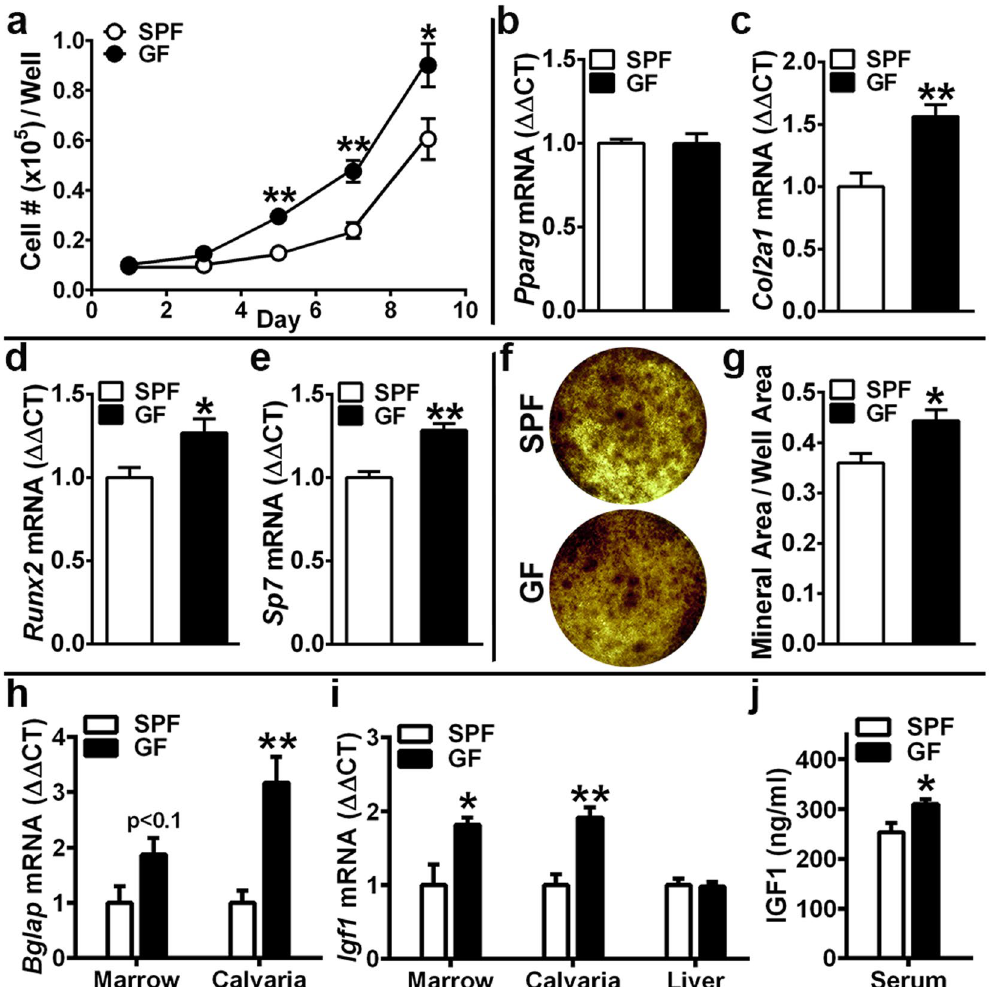
Figure 2. Osteoblastogenesis investigations. ( a – g ) Bone marrow stromal cell (BMSC) in vitro osteoblastogenesis assays. 11 week-old male SPF & GF mice were euthanized; bone marrow harvested; BMSCs isolated for in vitro assays. ( a ) Cell expansion assay (n = 4/gp): cell numbers over time in culture. ( b – e ) BMSC differentiation potential assay (untreated day-4 pre-confluent cultures were harvested for qRT-PCR analysis) to assess intrinsic differentiation potential (n = 4/gp). ( b ) Pparg mRNA assessed as a marker of adipogenic potential. ( c ) Col2a1 mRNA assessed as a marker of chondrogenic potential. ( d ) Runx2 and ( e ) Sp7(Osterix) mRNA assessed as markers of osteoblastogenic potential. Relative quantification of mRNA was performed via the comparative C T method ( ΔΔ CT); Gapdh was utilized as an internal control gene; data expressed as fold difference relative to SPF. ( f , g ) von Kossa mineralization assay (21 day mineralization treatment) (n = 4/gp). ( f ) Representative von Kossa stained culture images. ( g ) Mineralization area per well area. ( a – g ) BMSC assays carried out in duplicate (two technical replicate) cultures; n-values represent biological replicates per group. ( h – j ) Commensal microbiota in vivo regulation of osteoblastogenesis. 11 to 12 week-old male SPF & GF mice were euthanized; tissues were harvested. (h,i) RNA was isolated from marrow (n = 4/gp), calvaria (n = 4/gp), liver (n = 6/gp) for qRT-PCR analysis of candidate osteogenic genes. ( h ) Bglap(Osteocalcin) mRNA assessed as a marker of mature osteoblast function, and ( i ) Igf1 mRNA assessed as a critical osteoblastic signaling factor. Relative quantification of mRNA was performed via the comparative C T method ( ΔΔ CT); Gapdh was utilized as an internal control gene; data expressed as fold difference relative to SPF. ( j ) Serum was isolated from whole blood (n = 10/gp); ELISA analysis of IGF1 levels. Data reported as mean ± SEM. * p < 0.05 vs. SPF; ** p < 0.01 vs.